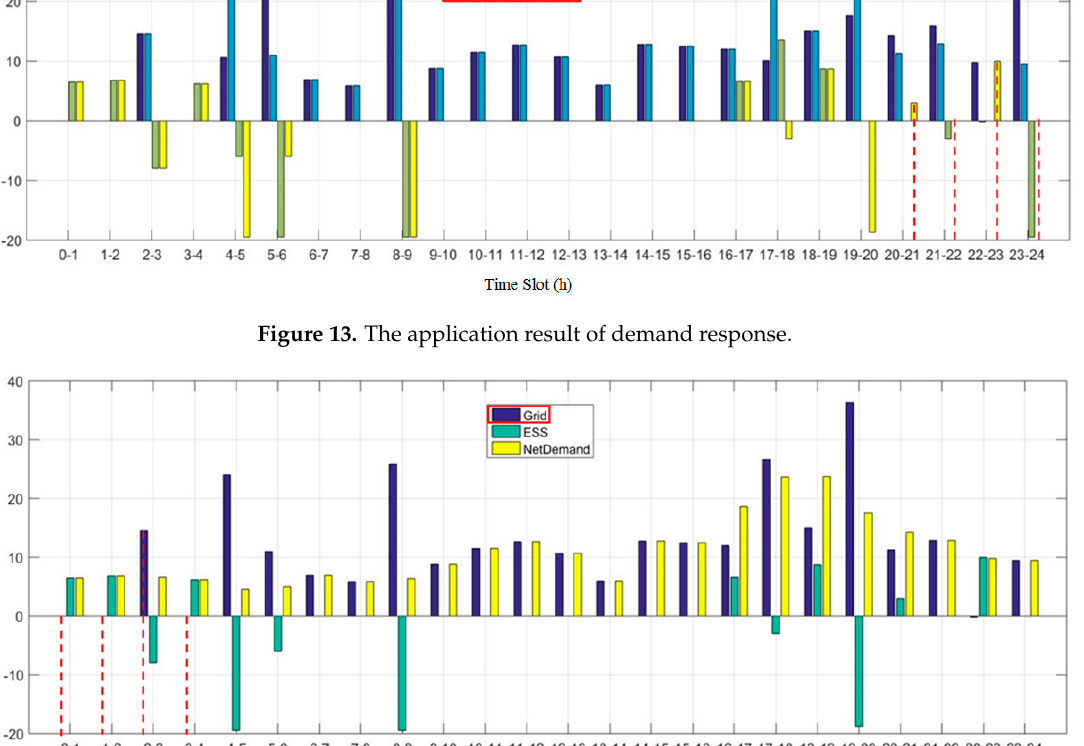
Figure 13. The application result of demand response.